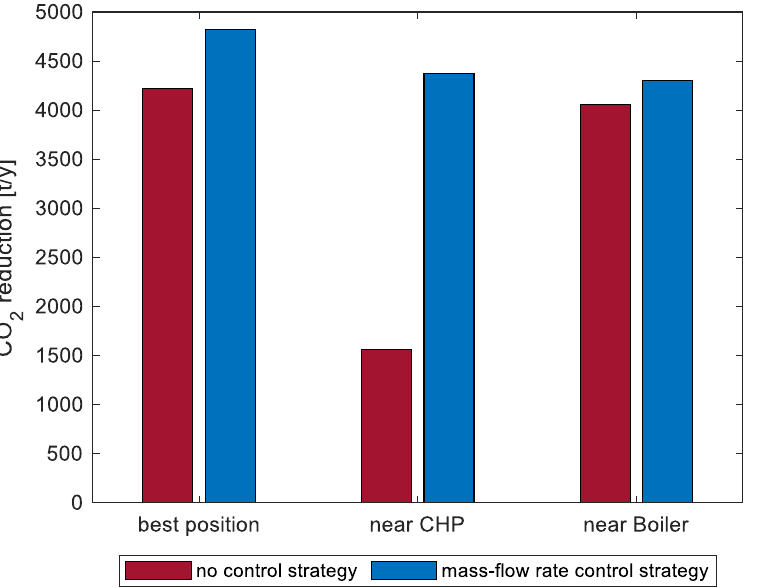
Figure 12. Comparison of the CO 2 emissions avoided with and without the control strategy proposed. Three HP locations are considered: (1) the best location, (2) near CHP2, and (3) near HOB1.